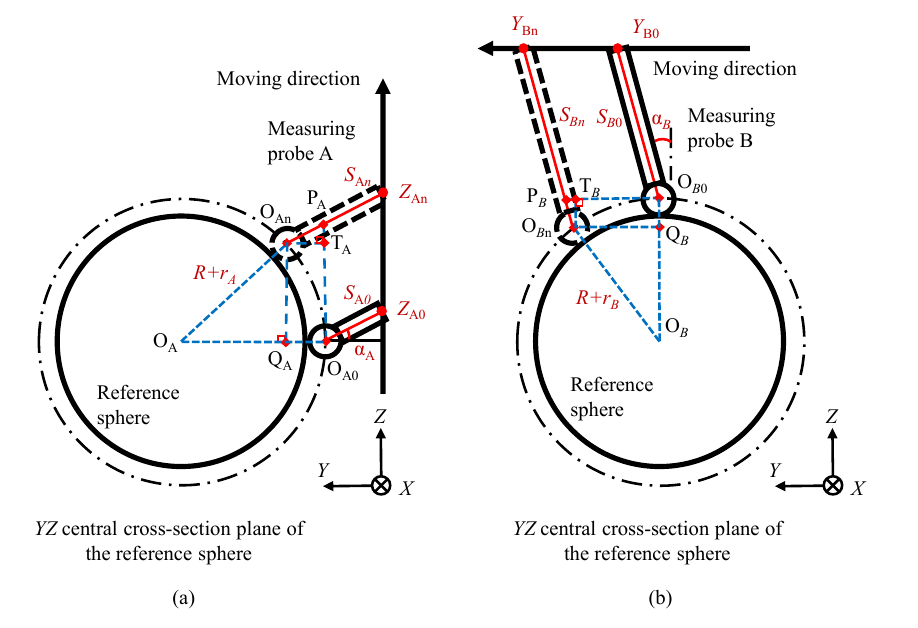
Figure 6. Schematic of tilt alignment of the measuring probes. ( a ) Schematic of the lateral probe (probe A) tilt alignment; ( b ) schematic of the axial probe (probe B) tilt alignment. The lateral displacement gauge, which is moved along the Z direction, is employed S A 0 to the position Z An , with the output of S An reaching the limited value of the measure- ment range. According to Figure 6a, in the right triangle of O An T A P A , we have the following